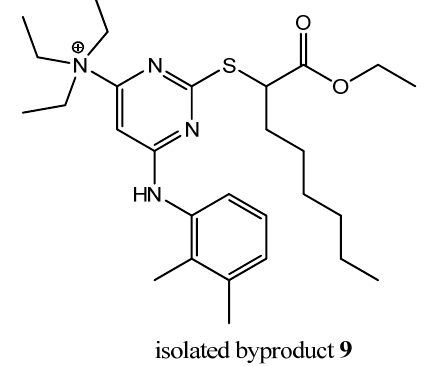
Figure 4. Chemical structure of the isolated byproduct 9 .